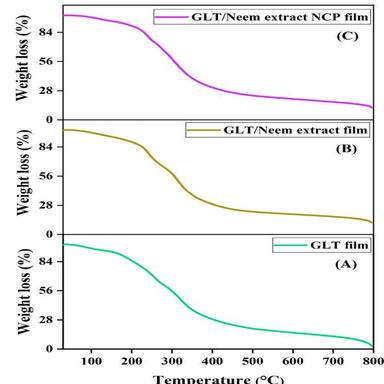
TGA thermograms of (A) GLT film, (B) GLT/Neem extract film, and (C) GLT/ Neem extract NCP film.